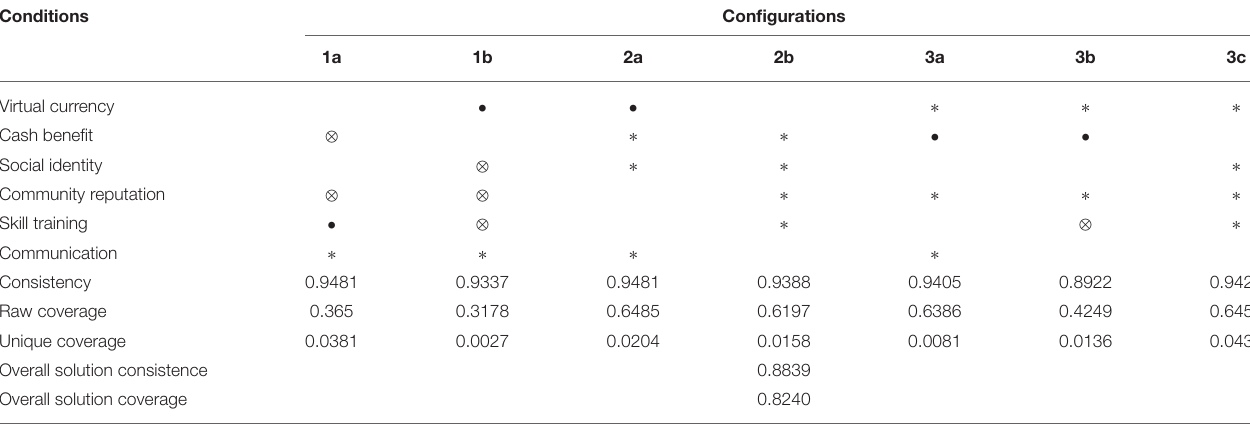
TABLE 5 | Causal configurations leading to SCA.